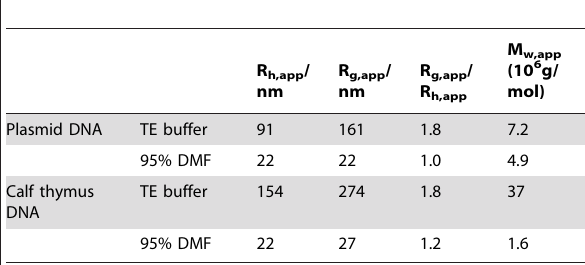
Table 1. LLS results of plasmid DNA and calf thymus DNA in TE buffer and in 95%DMF.